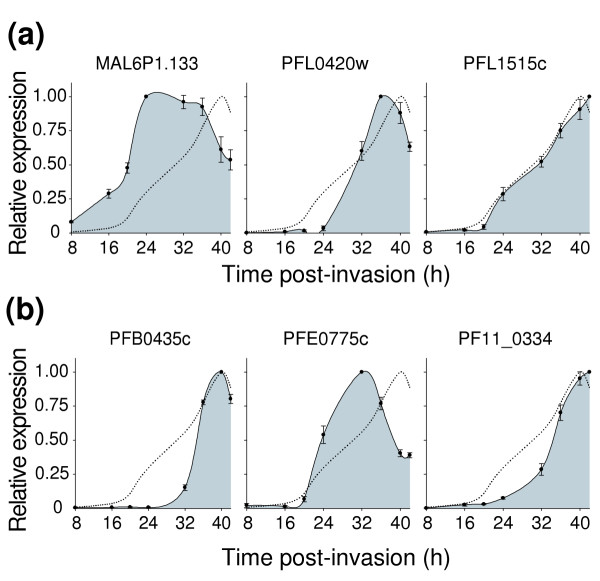
Stage-dependent gene expression of putative amino-acid transporters throughout the intraerythrocytic cycle of P. falciparum. (a) Amino acid/auxin permeases; (b) neurotransmitter:Na+ symporters. The analysis was carried out as described in the legend to Figure 4.